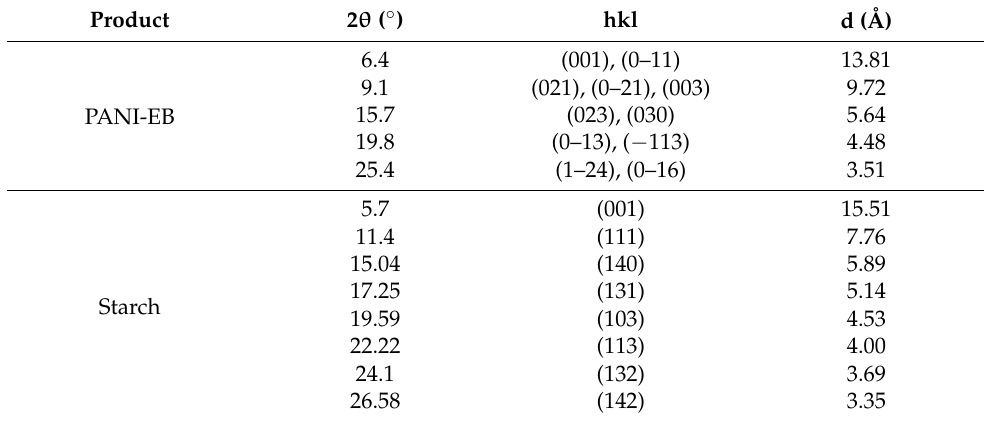
Table 4. Miller indices and diffraction spacing “d” of starch and PANI-EB.